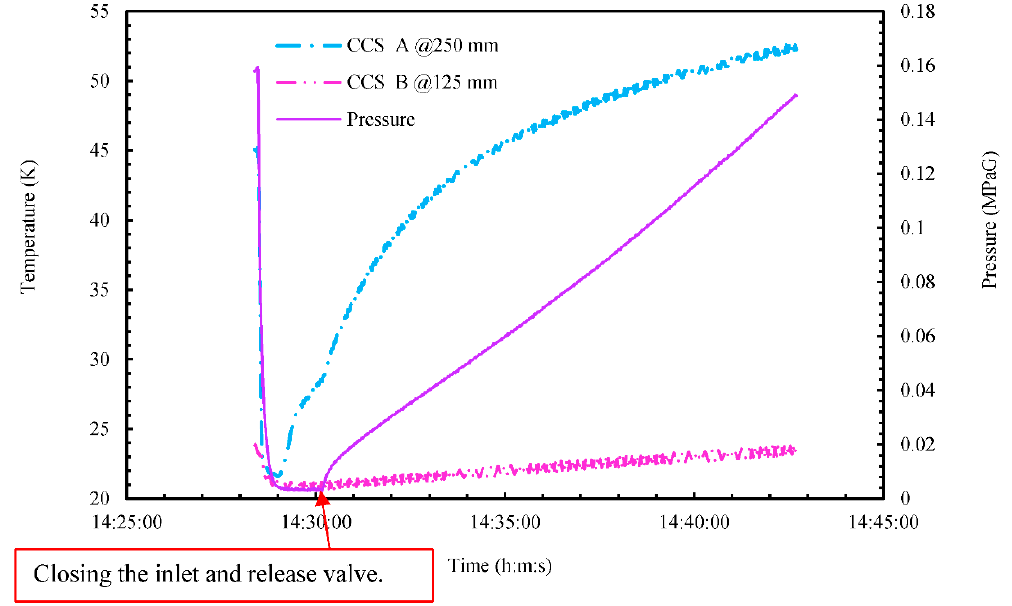
Figure 10. Time series of temperature and pressure inside the cryostat during marine-transportation test ⑤ from 14:28 to 14:42.